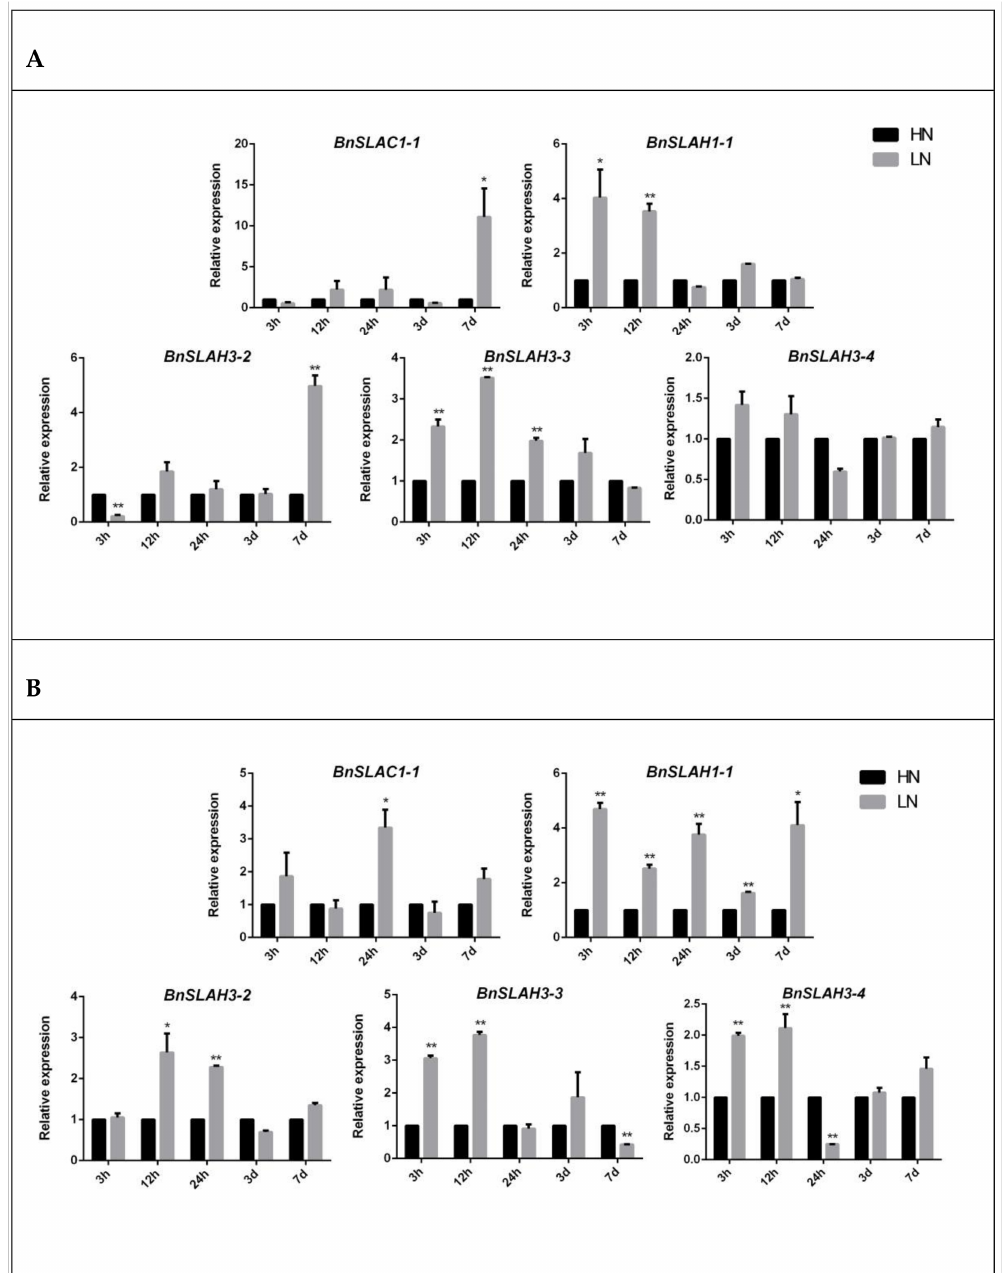
Figure 8. The expression patterns of selected BnSLAC/SLAH genes in leaves ( A ) and roots ( B ) after 3 h, 12 h, 24 h, 3 d and 7 d HN (7.5 mM) and LN (0.19 mM) treatment. The asterisk represents statistical significance (Student’s t -test, “*” p < 0.05, “**” p < 0.01) in comparison with control. The data are shown as mean values ± SE ( n =